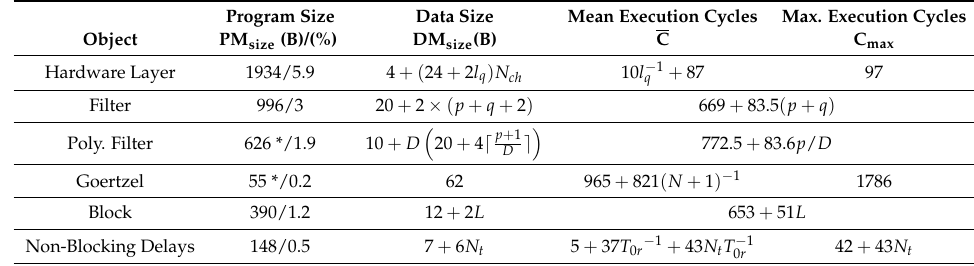
Table 5. Performances of the designed classes. Four parameters have been analyzed: program memory size, PM size ; data memory size, DM size ; number of clock cycles for some important class methods, on average, C or in the worst case C max . (*) The PM size must be increased by 996 if the filter class has not been previously loaded in